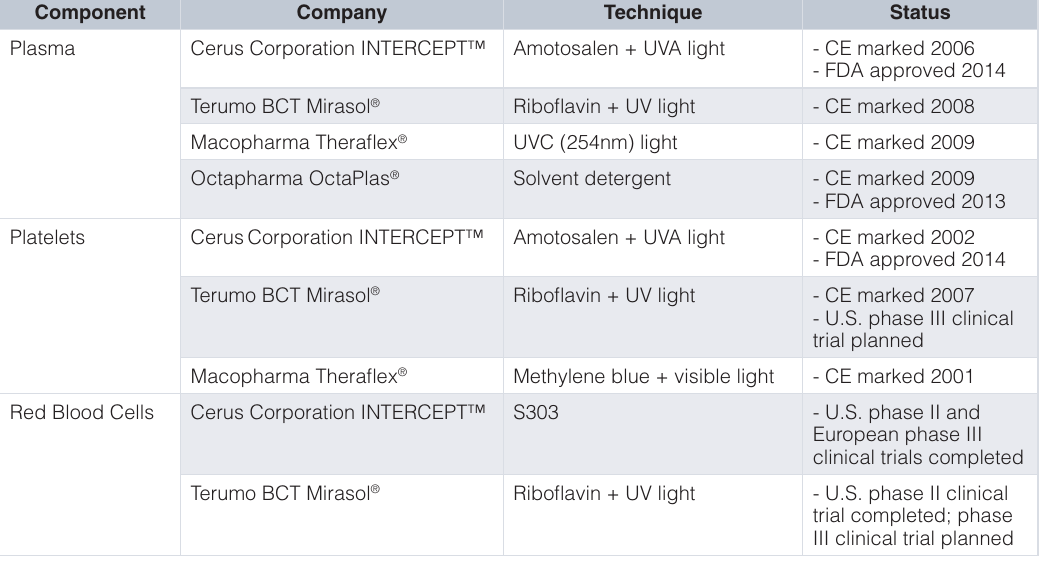
Table 3. Pathogen Reduction technology development and approval 16,19,20